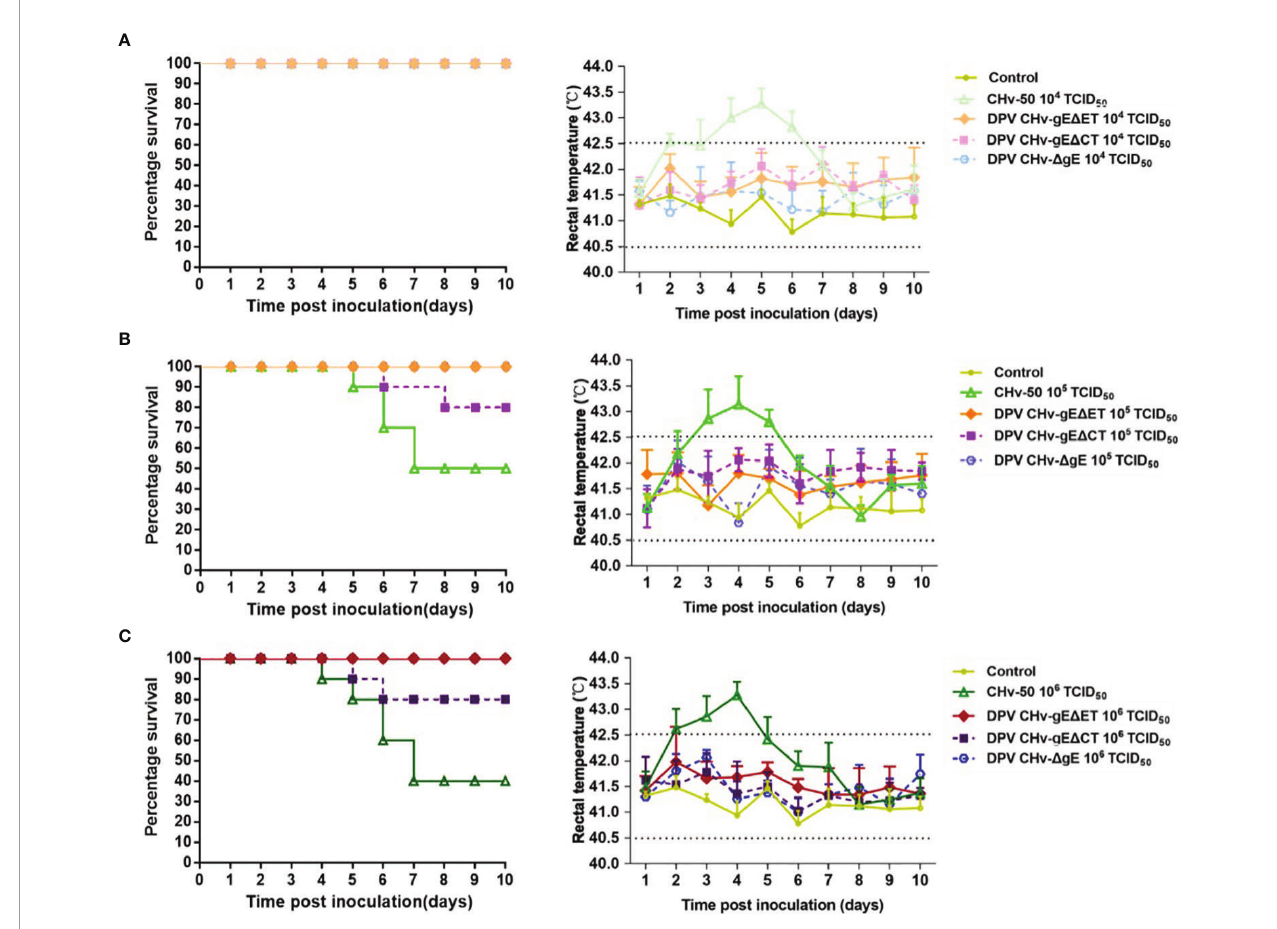
FIGURE 6 | Survival percentage (left) and rectal temperatures (right) of ducklings. (A) Inoculated with a dose of 10 4 TCID 50 of mutant viruses; (B) Inoculated with a dose of 10 5 TCID 50 of mutant viruses; (C) Inoculated with a dose of 10 6 TCID 50 of mutant viruses.